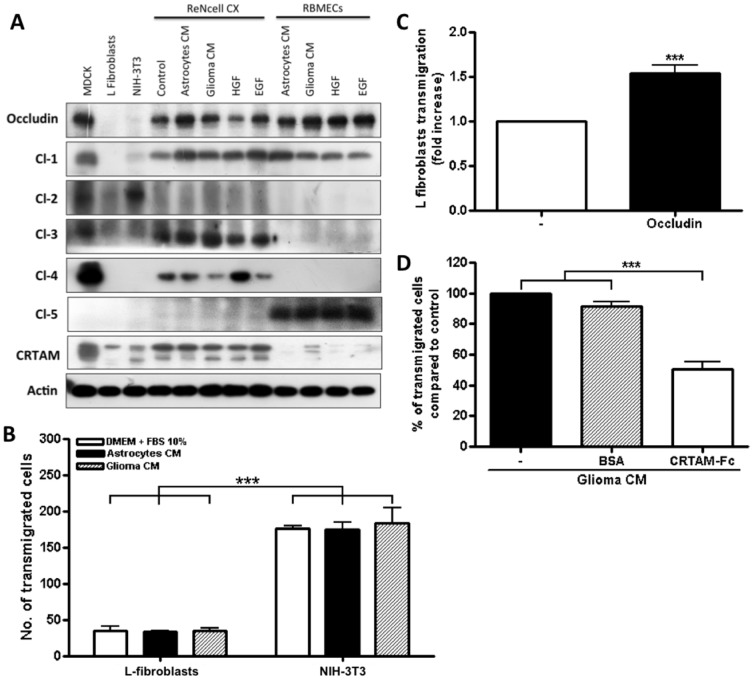
Expression of TJ proteins in transmigrating cells favors their passage across RBMECs.A) Analysis by Western blots of the expression of occludin, claudins 1 to 5 and CRTAM in NIH-3T3
and L-fibroblasts, ReNcells CX and RBMECs. B) The transmigration of NIH-3T3 and L-fibroblasts across
RBMECs is independent of the CM present in the basal compartment, but is significantly higher in
NIH-3T3 fibroblasts that express claudin-2 than in L-fibroblast that do not express TJ proteins.
N = 3, F(1,6) = 232.22, ***P<0.001; F(2,8) = 0.0895, ns = not significant; as assessed by two-way
ANOVA followed by Bonferroni's post hoc test. C) Exogenous expression of occludin in L-fibroblasts
enhances their transmigration across RBMECs monolayers. N = 9, t = 6.411, df = 8; ***P<0.001 as
assessed by Student's t-test. D) Competing CRTAM mediated adhesion with soluble human CRTAM
(CRTAM-Fc) added to the upper compartment of a Millicell insert, reduces transmigration of ReNcells
CX. N = 4, F(2,6) = 73.86; ***P<0.001, ns = not significant; as assessed by one-way ANOVA
followed by Bonferroni's post hoc test.